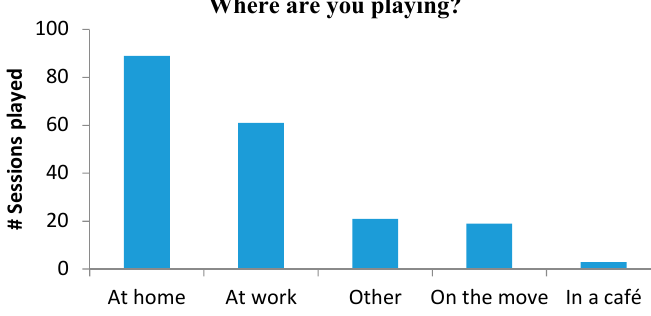
Figure 13. Total number of sessions played in a place.